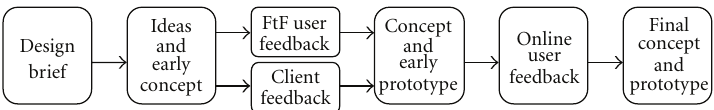
Figure 1: The design process in each of the four cases.